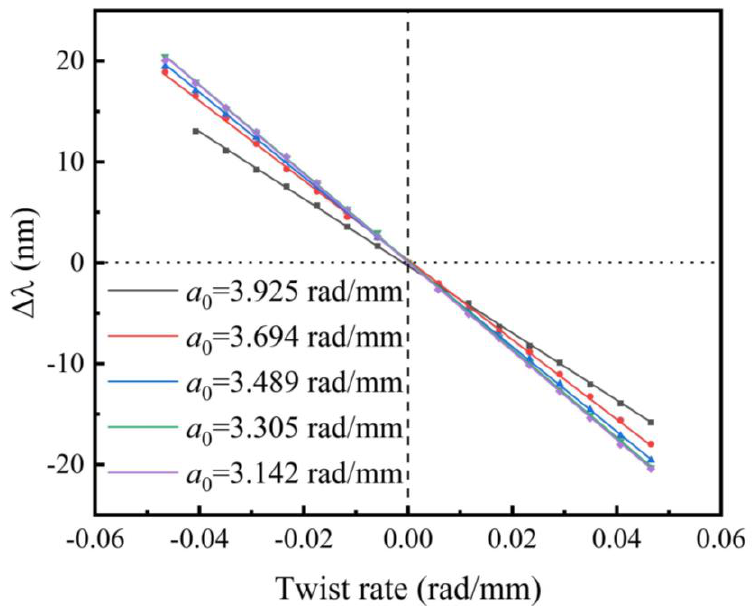
Figure 8. The resonant dip shift of the LFTPCF ( α 0 = 3.925 rad / mm) under an applied torsion in the Figure 8. T he resonant dip shift of the LFTPCF ( α 0 = 3.925 rad/mm) under an applied torsion in the range of − 0.057 to + 0.057 rad / mm in step of 0.0095 rad / mm. range of −0.057 to +0.057 rad/mm in step of 0.0095 rad/mm.